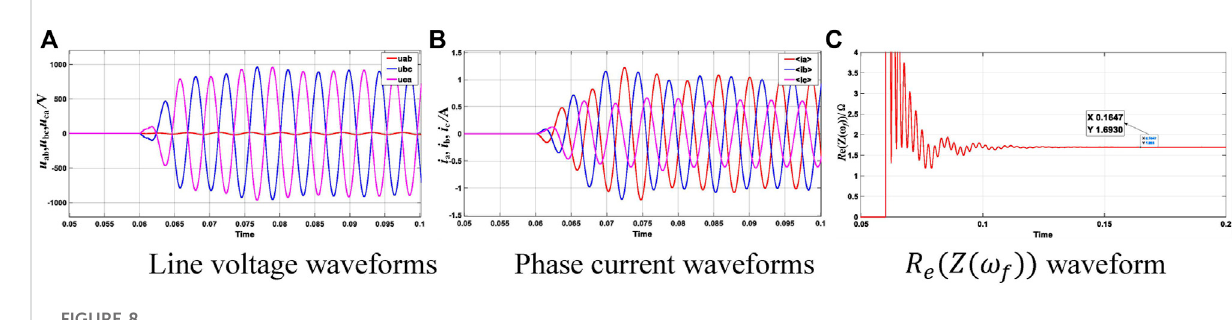
FIGURE 8 Permanent two-phase short circuit fault at middle of Line1.